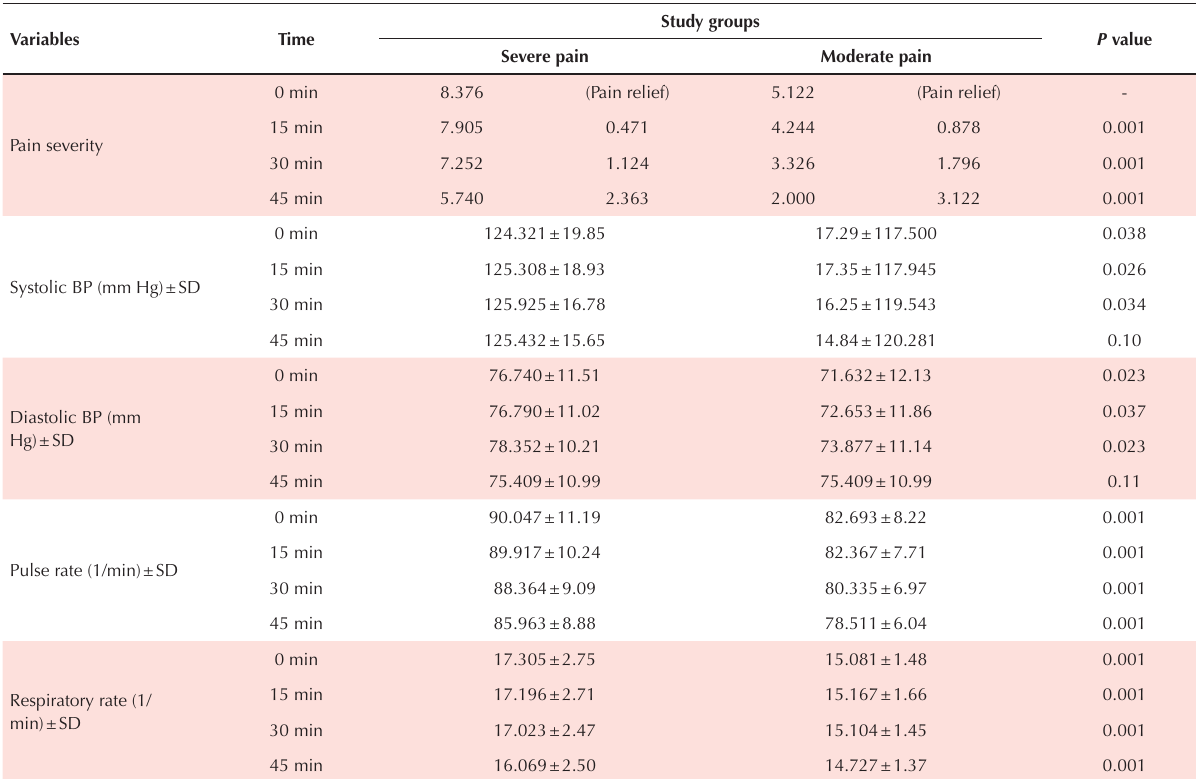
Table 2. Comparing the study outcomes and pain severity at different times for the two groups